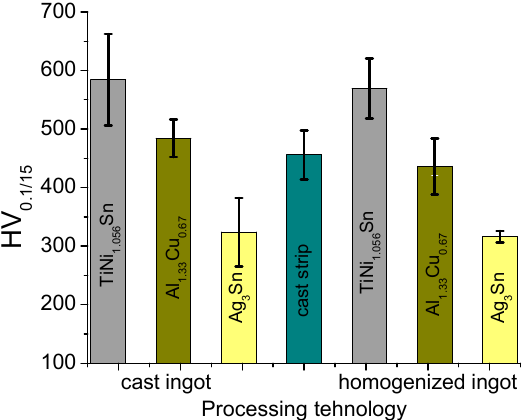
Figure 5. Microhardness values of different samples of the equimolar AlAgCuNiSnTi alloy. The microhardness values obtained for the analyzed multicomponent alloy are lower than those considered to be characteristic of high entropy alloys